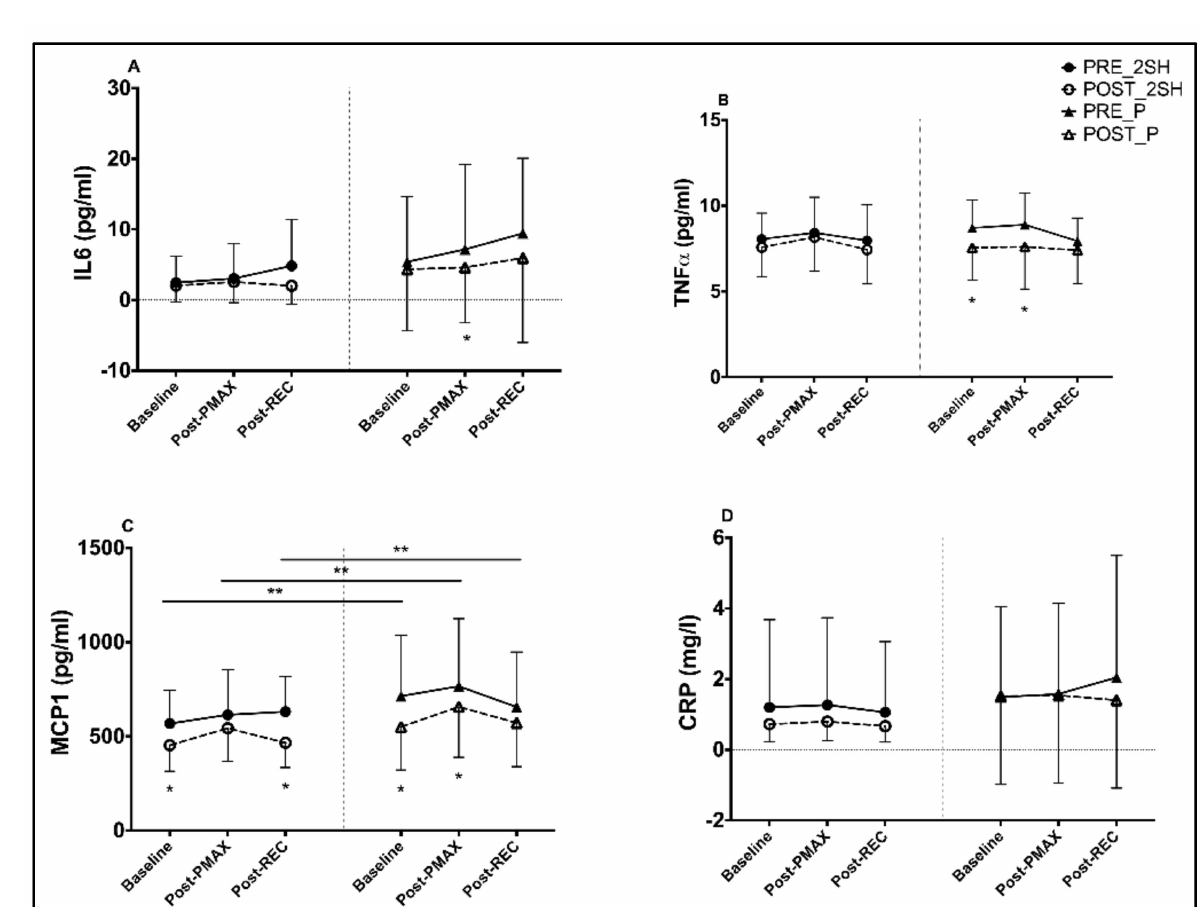
Figure 4. Differences between pre- and post-intervention intragroup and intergroup in inflammatory parameters at different points of the rectangular test ( A – D ). ( C ) a significant difference appears, comparing baseline ( p = 0.043), Post-P MAX ( p = 0.026) and Post-REC ( p = 0.045) of the second rectangular test between groups. * p < 0.05. ** p < 0.05 between post-intervention time points of rectangular test between groups (2S-hesperidin vs.